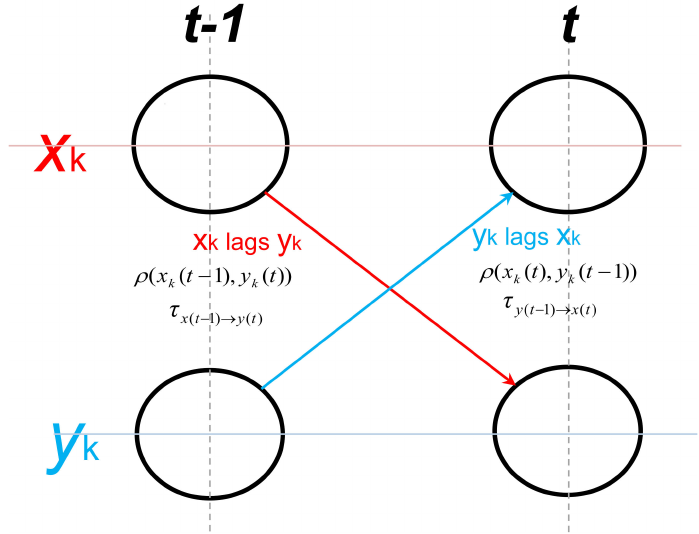
Figure 3. The basic scheme of the interaction between two singular vectors resulting from a Maximum Covariance Analysis (MCA) between two variables x and y assuming 1